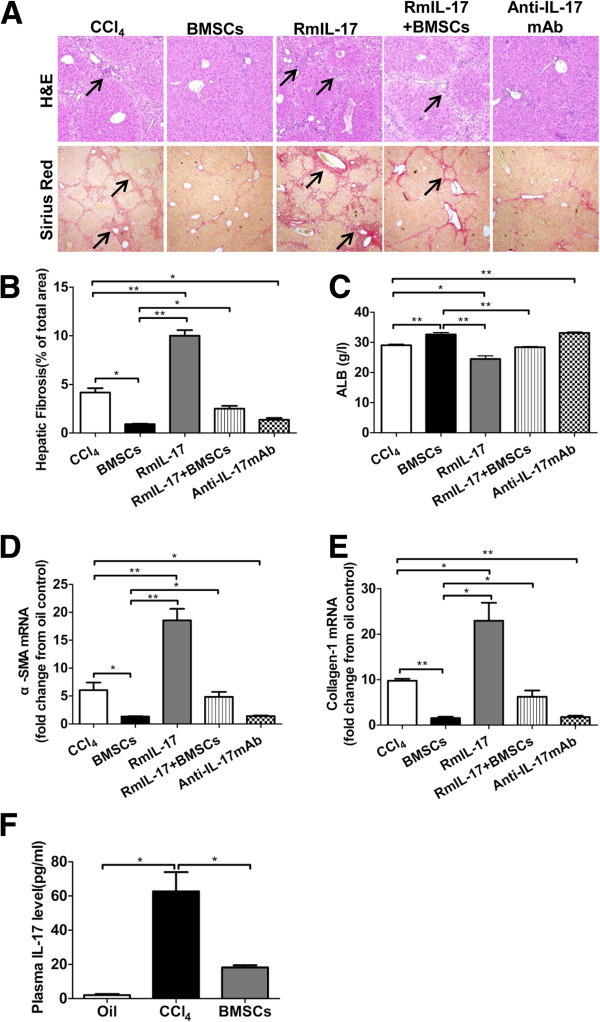
IL-17 is a key for BMSCs-mediated amelioration of liver injury induced by CCl4 injection. After 6 weeks of CCl4 administration to induced liver injury, the mice were randomly divided into several groups and were given a tail vein injection of BMSCs (5 × 106 cells in 0.2 ml PBS), a intraperitoneal injection of rmIL-17, a intraperitoneal injection of rmIL-17 and a tail vein injection of BMSCs, and five intraperitoneal injections of anti-mouse IL-17 mAb, respectively. Then the mice continued to be given CCl4 injection during our study to maintain liver fibrotic status. One group mice were only given CCl4 injection during the whole study and served as control. (A) Liver inflammatory (upper panels arrowhead) and hepatic collagen deposition (lower panels arrowhead) were determined by H&E and Sirius red staining. Original magnifications: left panels × 100, right panels × 40. (B) The percentage of stained red area of Sirius red was assessed at 100 × magnification with a quantitative image analyzer. (C) Serum chemistry of liver function was performed for albumin (ALB). The expressions of alpha- smooth muscle actin (SMA) (D) and collagen-1 (E) mRNA in liver tissues were measured by real time (RT)-PCR. (F) The plasma IL-17 level was analyzed by enzyme-linked immunosorbent assay (ELISA). Results represent means and standard deviation (SD) of at least five mice per group. BMSCs, bone marrow-derived stem cells. *p < 0.05, **p < 0.01.